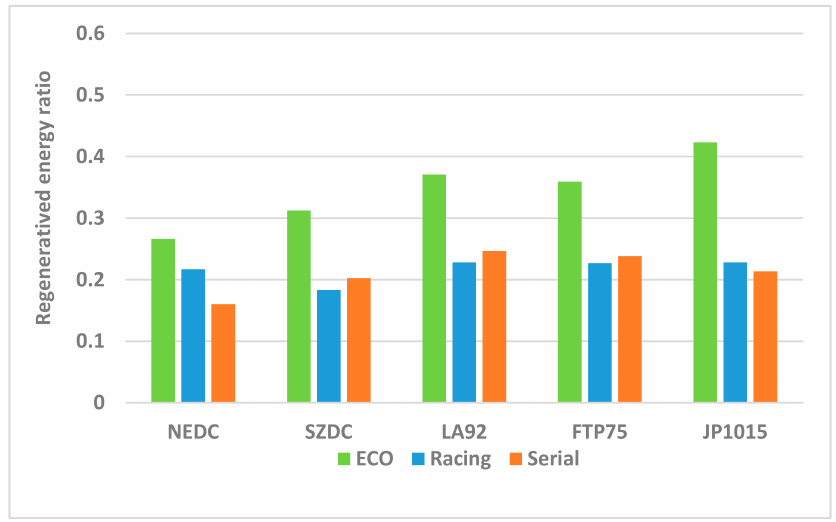
Figure 22. RBS recovery potentials in various driving